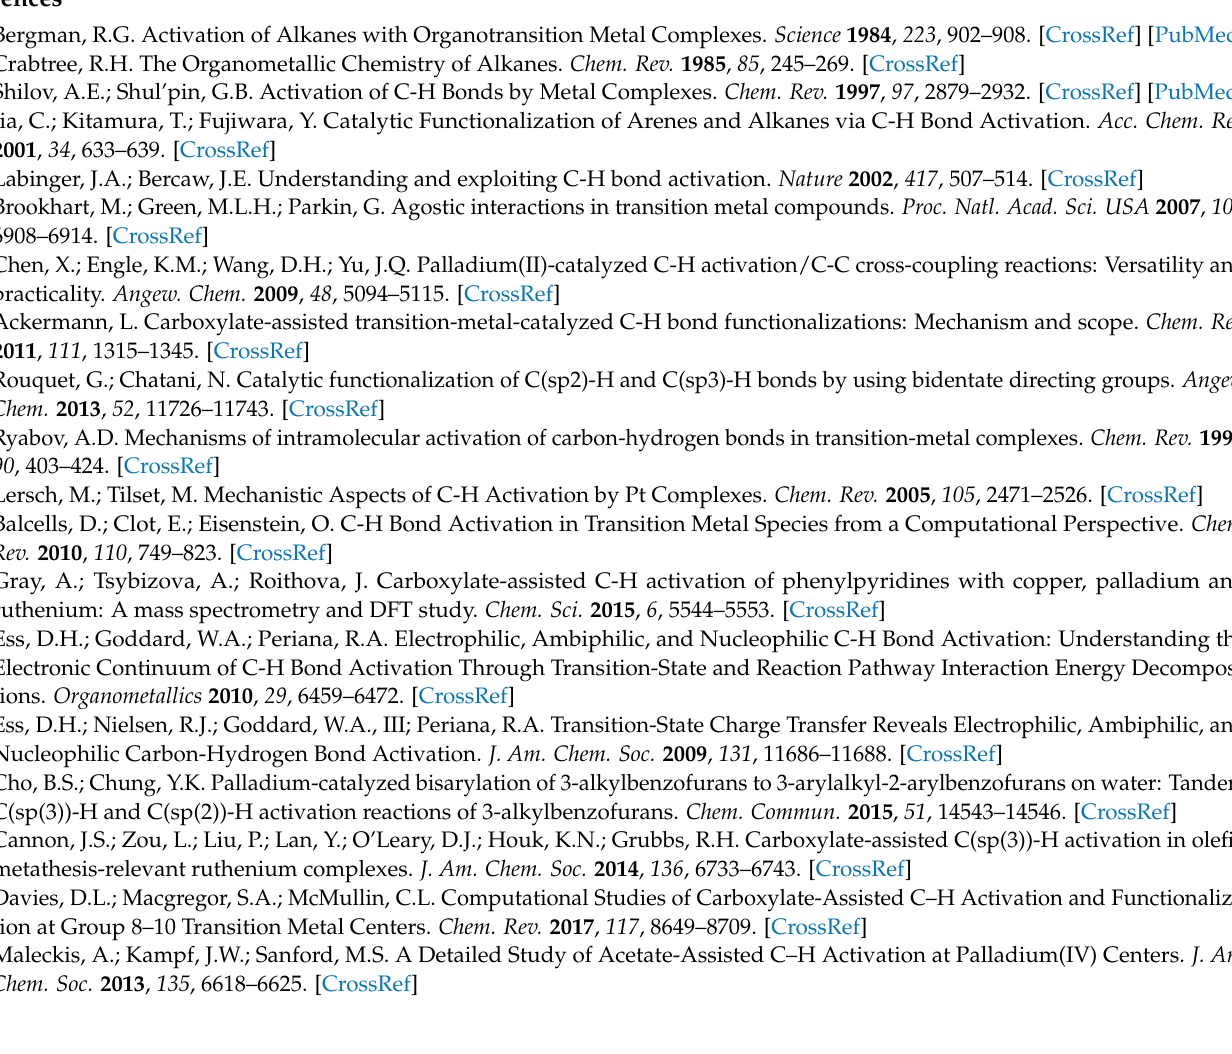
Table S1: Energies of local minima stationary points; Table S2: Energies and imaginary frequencies of transition states; Table S3: Atomic coordinates for stationary points; Figure S1: Free energy reaction profile for the generation of IV and V from II; Table S4: Optimized structural parameters, Wiberg bond indices, n0 values, and deviation angle of ipso hydrogen of intermediate states; Table S5: Mapped surfaces of electrostatic potential of intermediate states; Table S6: Distortion–interaction